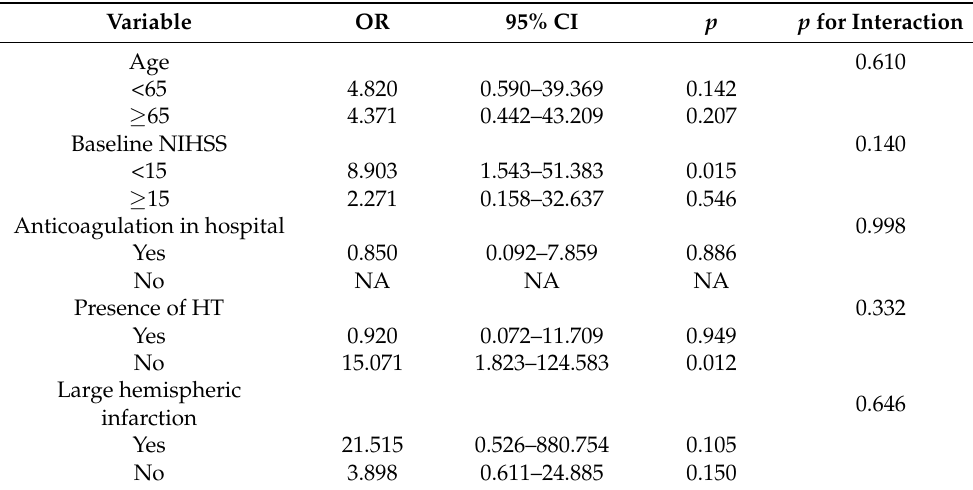
Table 4. Stratified analyses to identify variables that may modify the association between severe DMVs and three-month functional